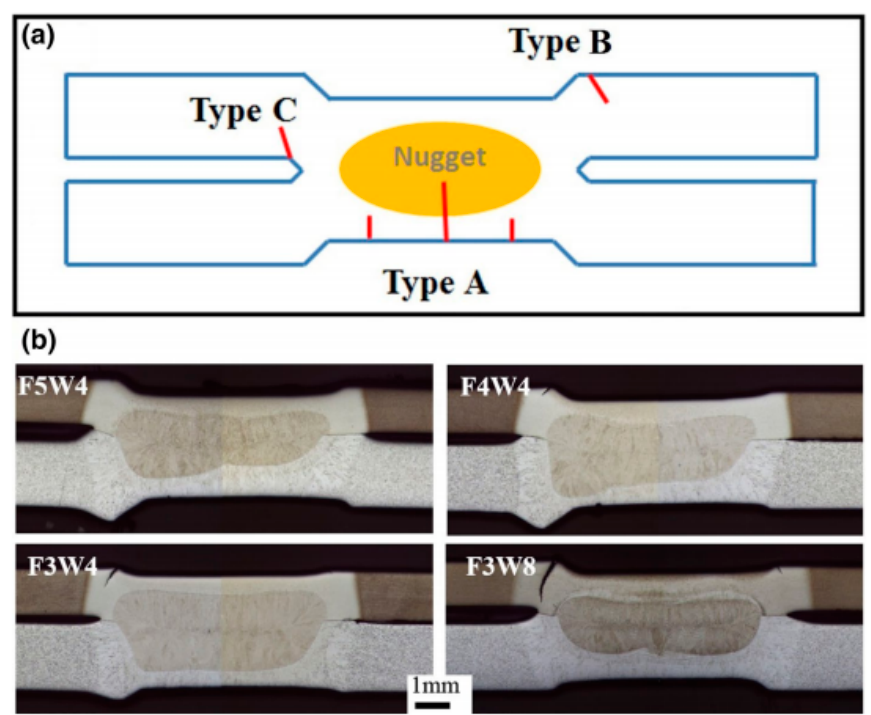
Figure 4. ( a ) Schematic diagram for classification of LME cracks at various locations, and ( b )